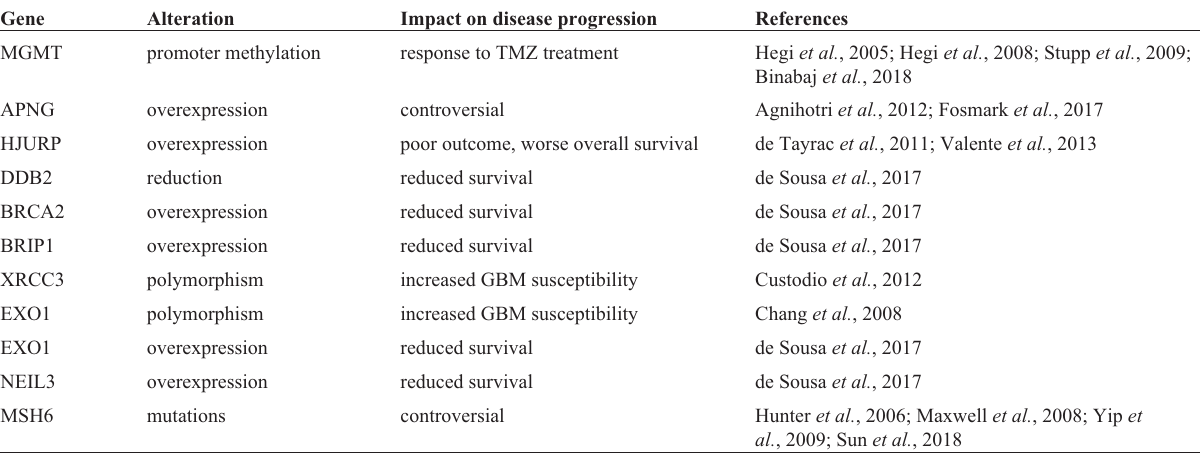
Table 3 - DNA repair genes considered biomarkers* of GBM susceptility and/or progression.